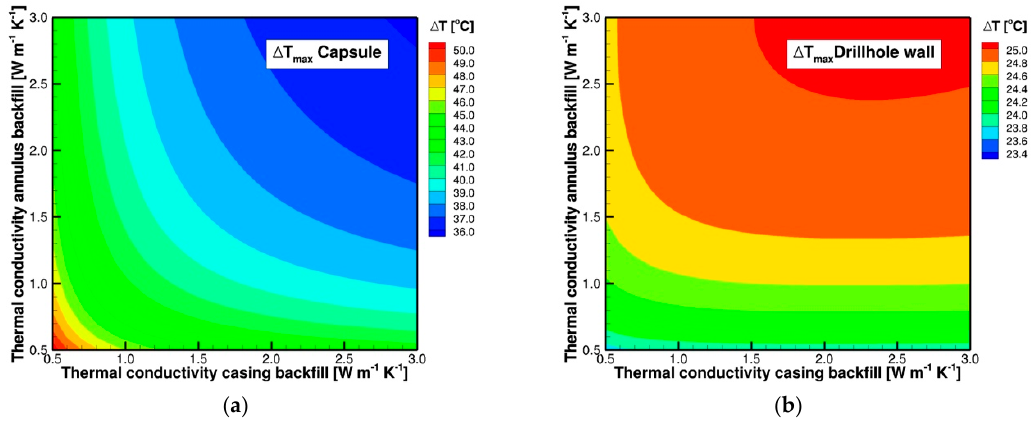
Figure 6. Response surfaces of maximum temperature increase as a function of casing-backfill and annulus thermal conductivities for a 100 W initial heat output for the following repository components: ( a ) waste capsule; and ( b ) drillhole wall.